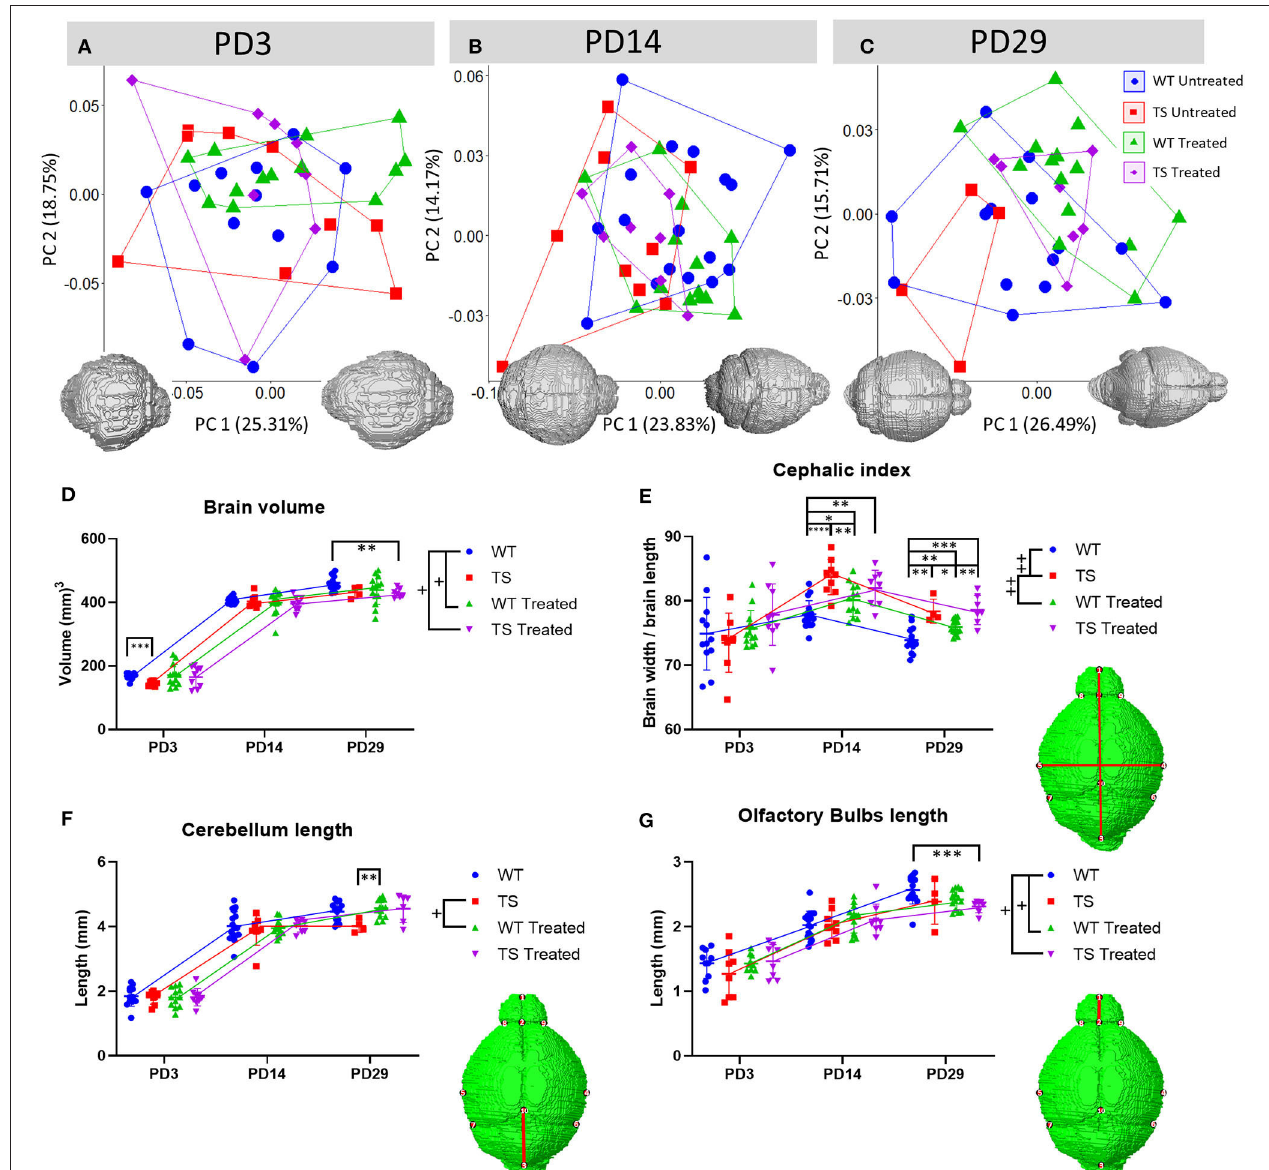
FIGURE 2 | Postnatal brain anatomy alterations in Ts65Dn mice and modulatory effects of perinatal GTE-EGCG treatment. (A–C) Brain shape variation assessed by a Principal Component Analysis (PCA) based on landmarks registered on the 3D brain reconstructions segmented from in vivo µ MRI scans at (A) PD3, (B) PD14, and (C) PD29. Each symbol represents one mouse. All scatter plots are presented along with the morphings associated with the negative and positive values of the PC1 axis. Morphings represent shape changes associated with PC scores of 0.1 and − 0.1. (D) Brain volume, (E) cephalic index (estimated as the ratio between the width and length of the brain), (F) length of the cerebellum and (G) length of the olfactory bulbs at PD3, 14 and 29. Data are presented as mean ± standard deviation. See Supplementary Figure S1 and Supplementary Table S3 for more details about how lengths and distances for the brain structures were estimated. + sp < 0.05; ++ p < 0.01; Mixed-effects analysis across timepoints; * p < 0.05; ** p < 0.01; *** p < 0.001; **** p < 0.0001; Mann Whitney tests by timepoint. Sample size: (PD3) WT = 12 (10 olfactory bulbs), TS = 8, WT Treated = 13 (12 cerebellum length, 11 olfactory bulbs), TS Treated = 9 (nine olfactory bulbs); (PD14) WT = 17, TS = 9, WT Treated = 13, TS Treated = 8; (PD29) WT = 14, TS = 4, WT Treated = 14, TS Treated = 7 (six cerebellum length). The mice analyzed may differ across stages but represent overall ontogenetic trajectories. = 0.011) and WT untreated mice ( P -value = 0.016) ( Figure 2C